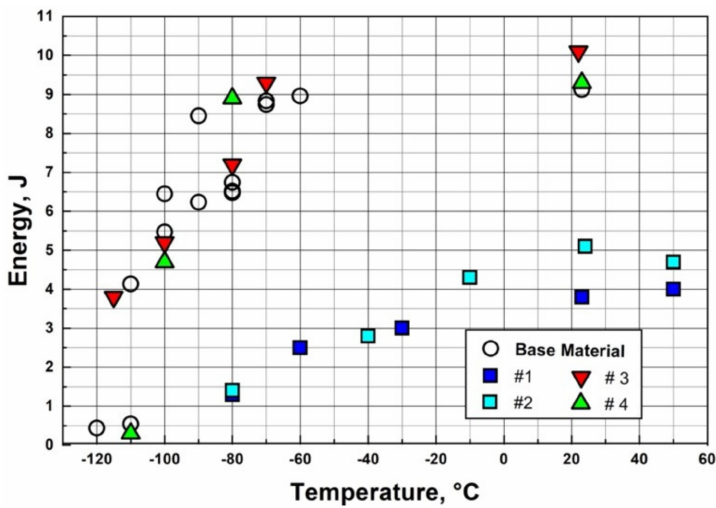
Figure 26. Charpy test results of samples with surface machining procedure # 1–4 according to Table 4 after diffusion bonding by one HIP cycle at 25 MPa/1050 ◦ C/2 h, followed by a standard heat treatment at 980 ◦ C/0.5 h, air quenching, and 760 ◦ C/2